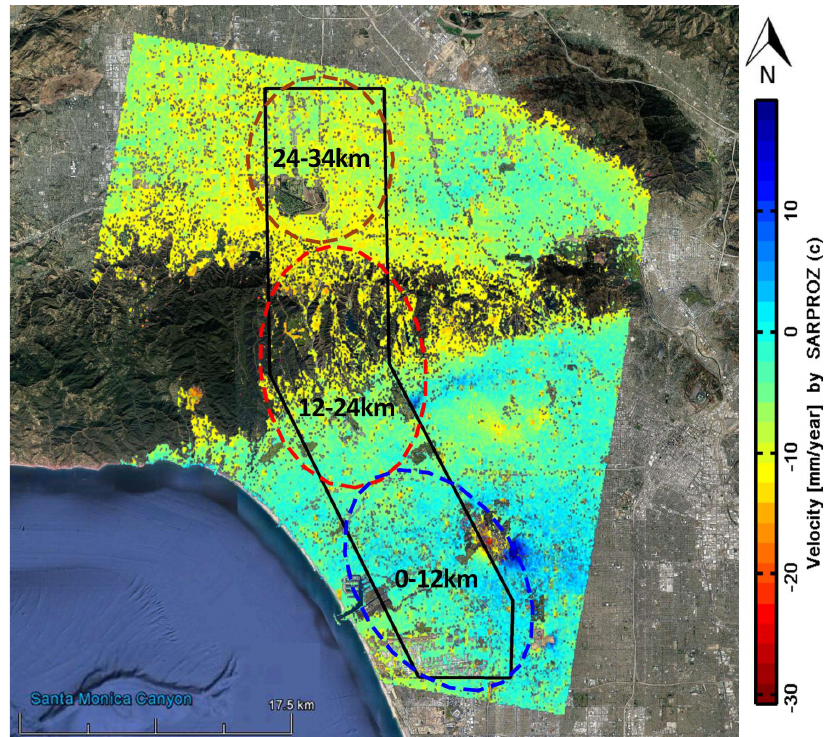
Figure 4. Mean velocity map of land deformation (mm/yr) in the region covering a period between June 2017 and May 2018 overlapped onto Google Earth high-resolution imagery. The black line shows the boundary of Sepulveda Transit Corridor study area. The corridor categorized into three zones based on the trend of displacement rates: (a) from 0 to 12 km; (b) from 12 to 24 km; and (c) from 24 to 34 km.